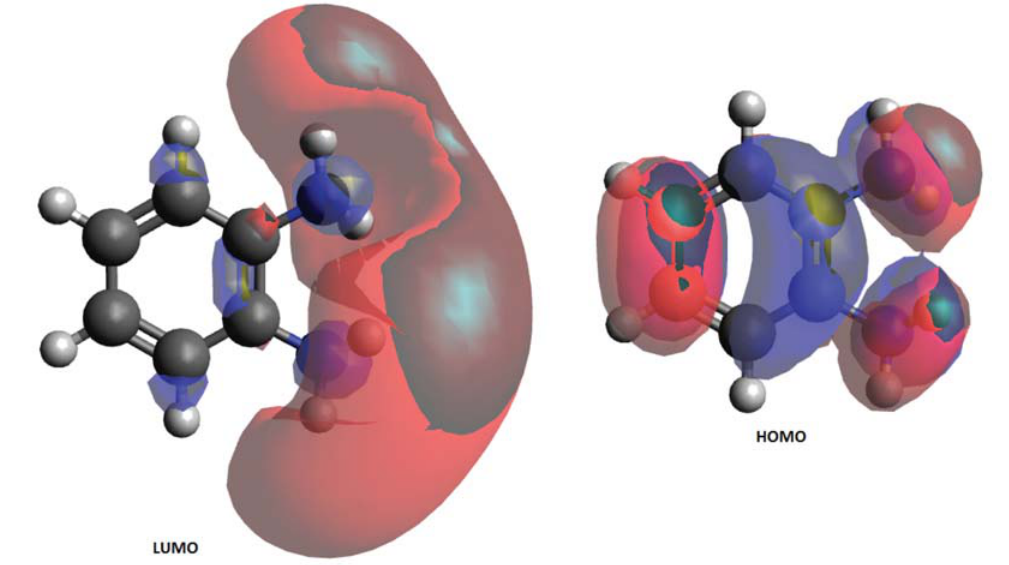
Figure 6. The atomic orbitals compositions of the frontier molecular orbital for o